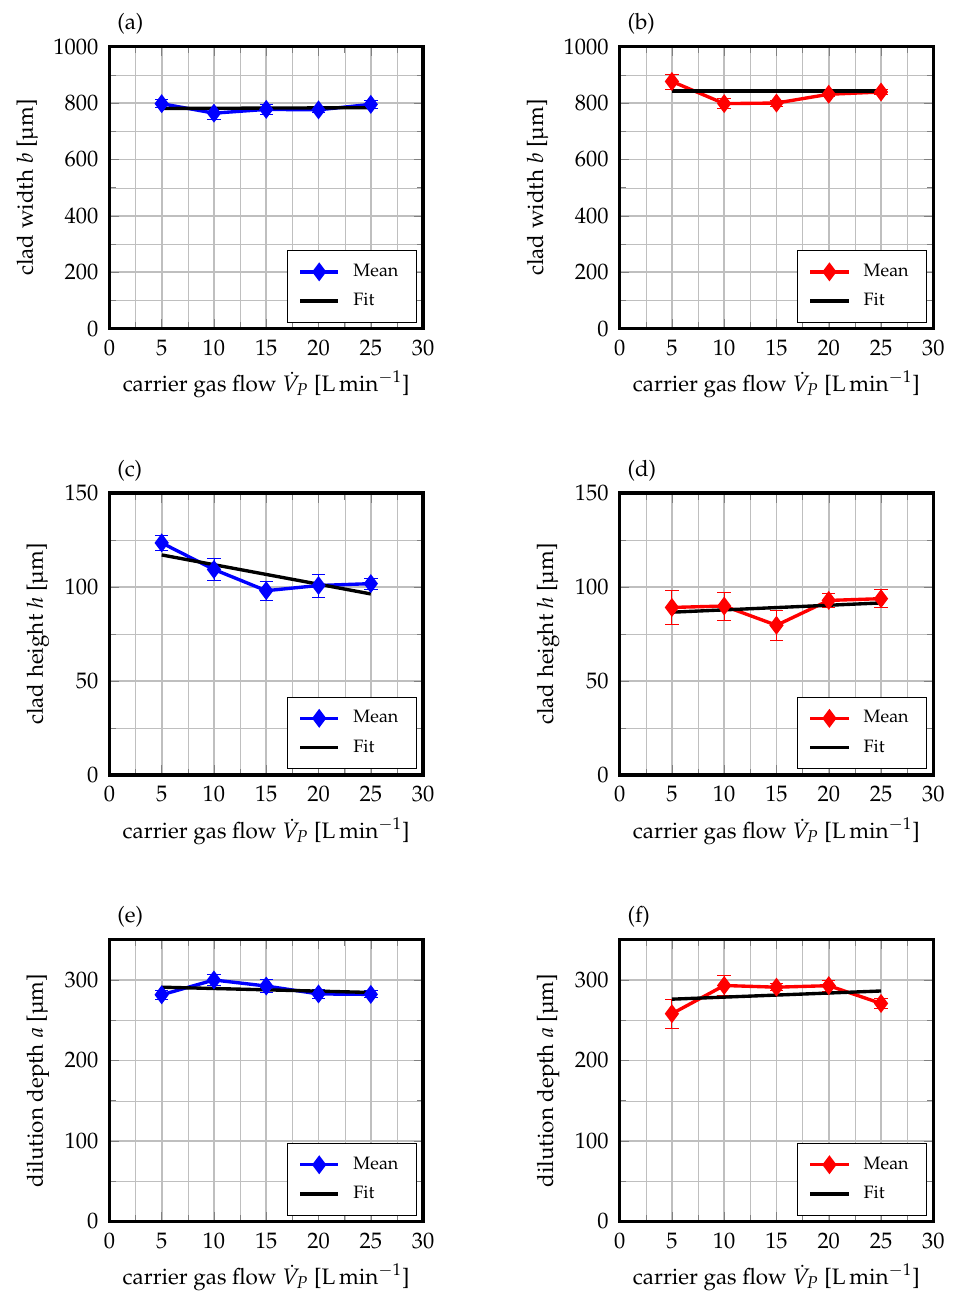
Figure 3. Target values of clad width b , clad heigth h , and dilution depth a for varying carrier gas flow rates ˙ V P at a constant shielding gas flow rate ˙ V S . Mean values of five measurements, with standard error of the mean (SEM). ( a , c , e ): 20–53µm, ( b , d , f ):